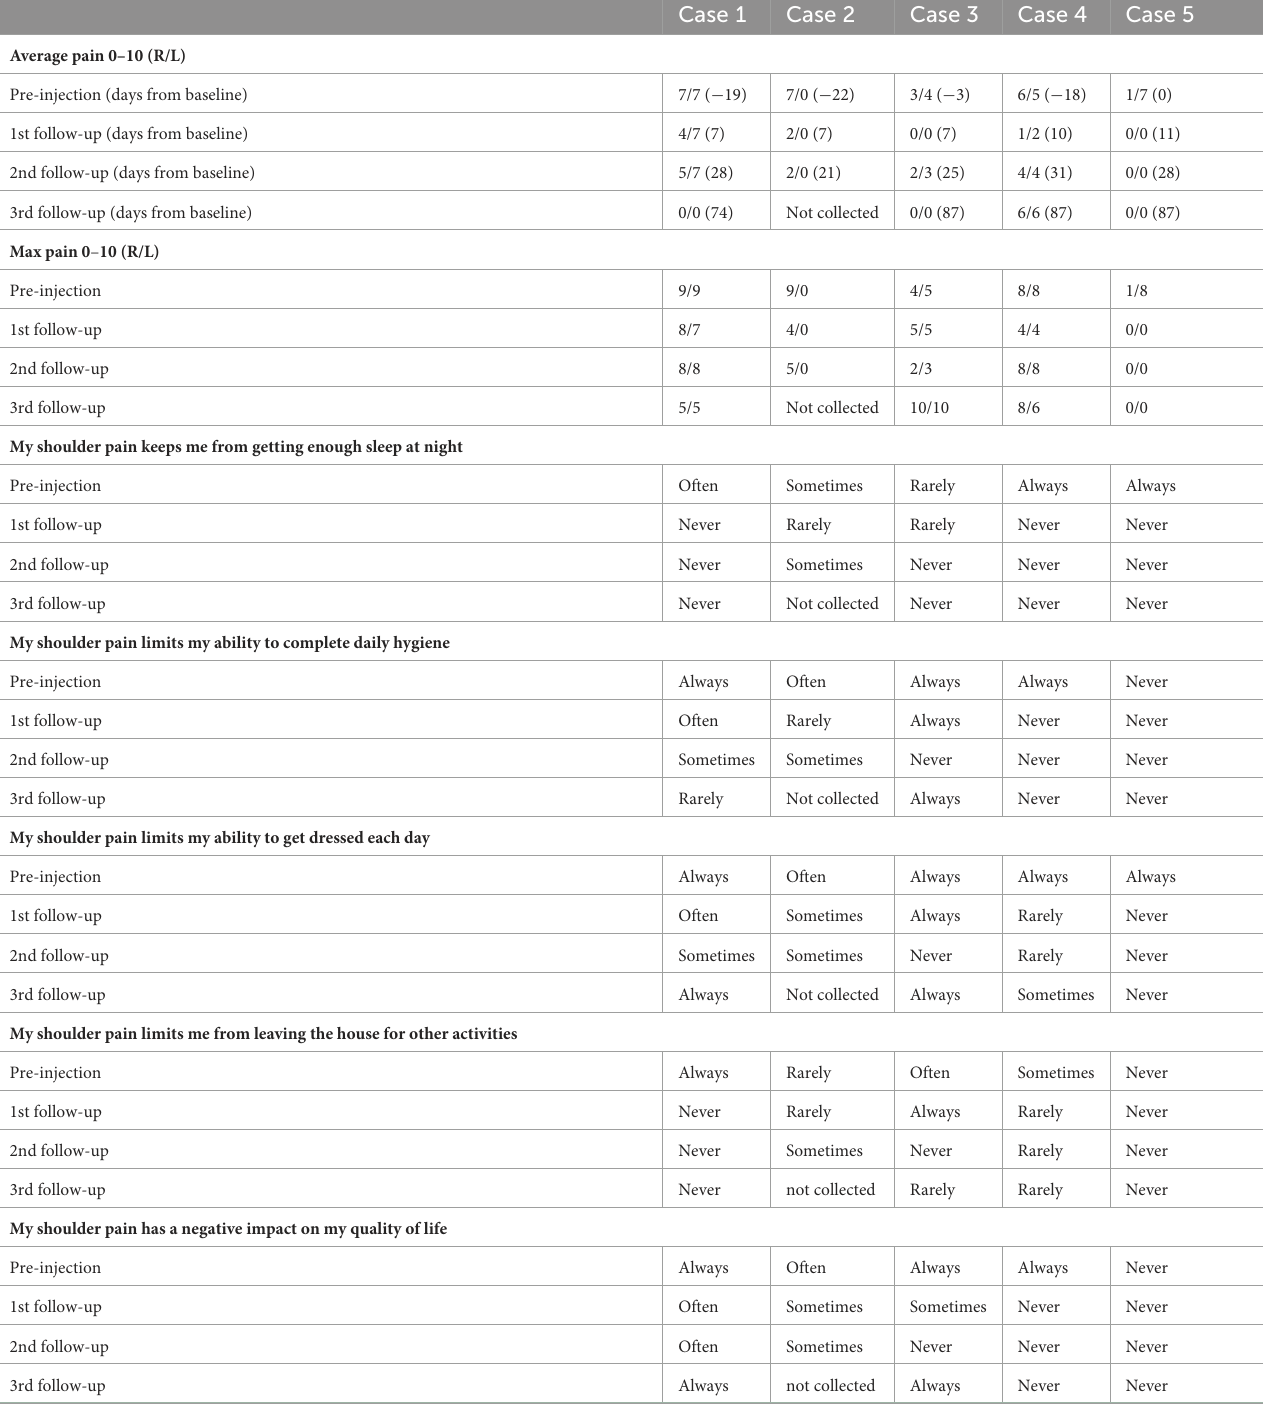
TABLE 1 Pain and impact on sleep, function, and quality of